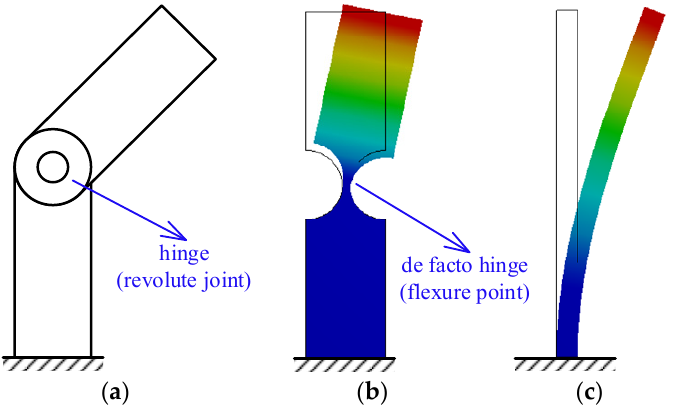
Figure 1. Drawings related to the de facto hinge phenomenon: ( a ) the revolute joint of two rigid bodies; ( b ) the flexure point of a structure; ( c ) the distributed compliant mechanism.